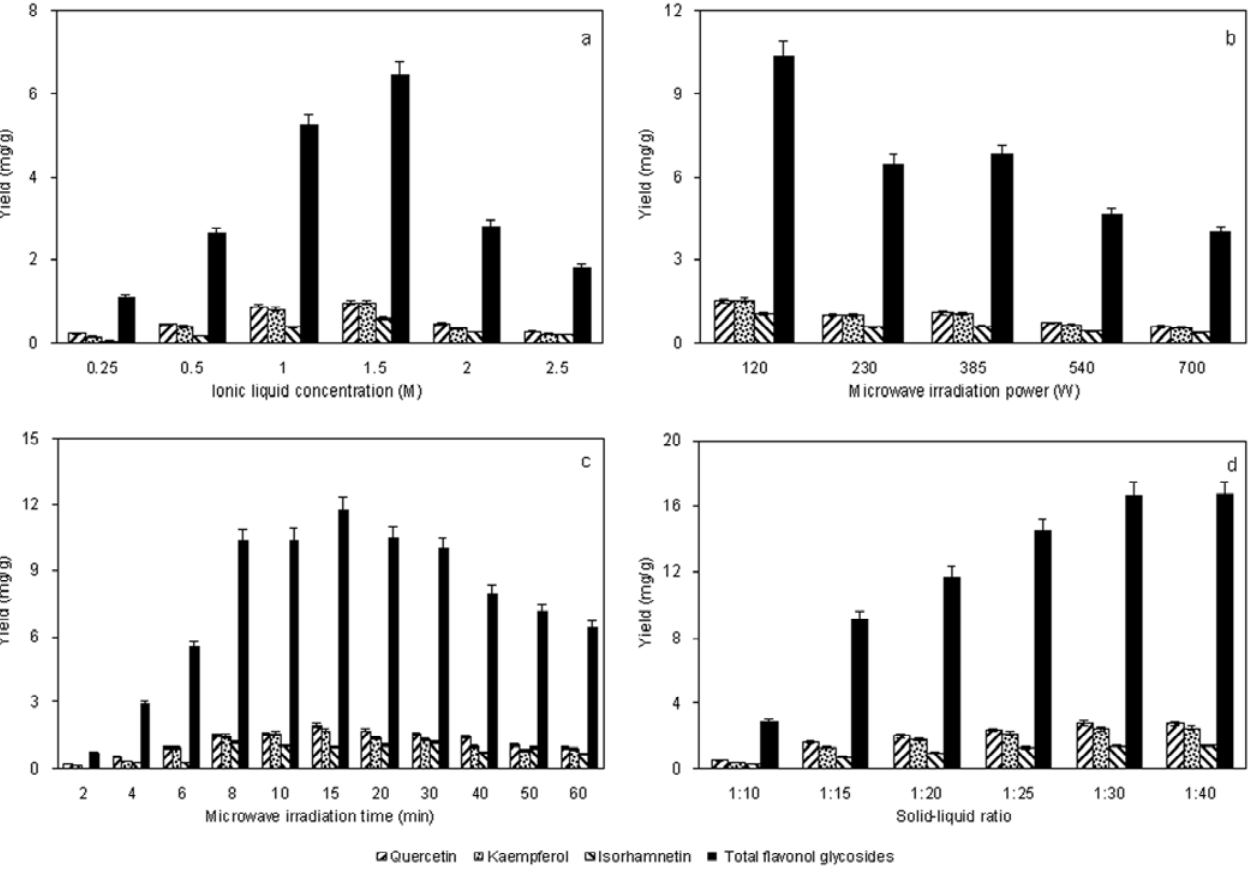
S(CH ) mim]HSO 3 2 4